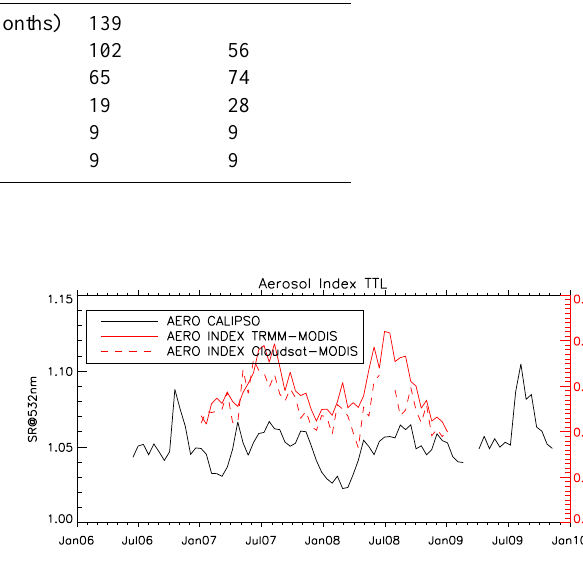
Table 3. Average mass flux in 10 8 kgs − 1 and time constant ( τ ) in month, required for a (SR-1) decrease by 63% in the TTL between calculations by Corti et al. (2005) on yearly average basis and by Yang et al. (2008) during the NH winter only. Altitude Mass flux from CALIPSO From Corti From Yang (10 8 kg s − 1 )